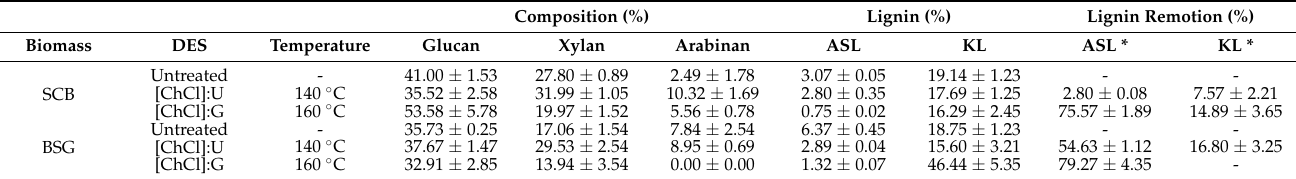
Table 2. Biomass composition before and after DES pretreatment. Composition (%) Lignin (%) Lignin Remotion